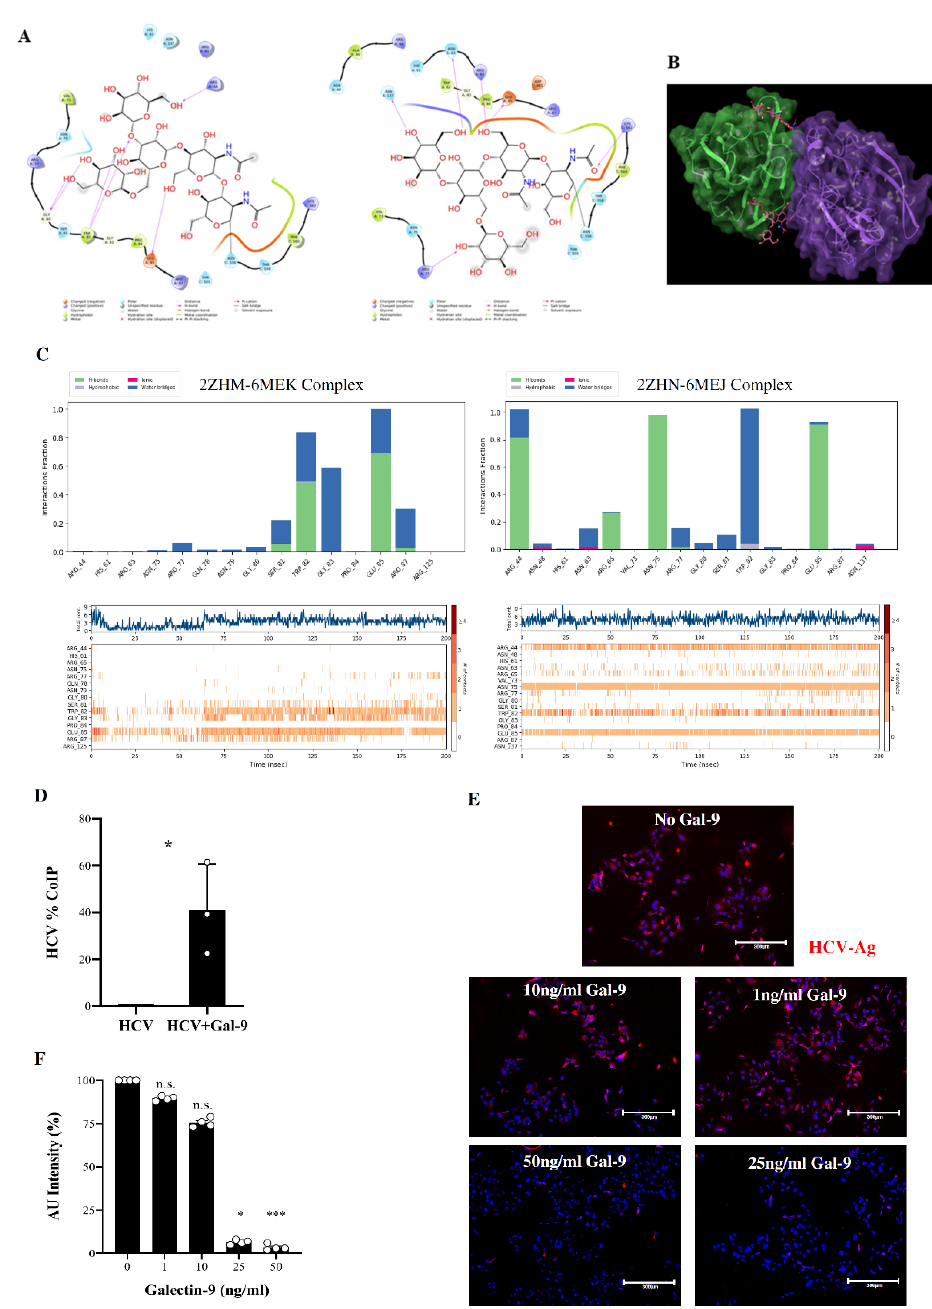
Figure 6. In silico and functional characterization of neutralizing interactions between HCV and galectin-9. ( A ) On the left, ligand interaction diagram of HCV E2 carbohydrate from PDB 6MEJ and galectin-9 CRDs from PDB 2ZHM; on the right, ligand interaction diagram of HCV E2 carbohydrate from PDB 6MEK and galectin-9 CRDs from PDB 2ZHN. ( B ) Galectin-9 CRDs–HCV E2 complex retrieved from a selected docking pose. The green chain is the galectin-9 CRDs from PDB 2ZHN, the purple chain represents HCV E2 from PDB 6MEJ, and the pink molecules are the sugar moieties belonging to E2. ( C ) On the top, bar plots of the interactions established between galectin-9 CRDs and HCV E2 during the MD trajectories; on the bottom, frequency occurrence of the interactions between the protein partners in the MD timeframe. ( D ) Bar graph showing the percentage of HCV bound to galectin-9, as assessed with the co-immunoprecipitation (CoIP) assay. HCV without ga- lectin-9 was used as a negative control. Each dot represents a technical replicate. Statistical analyses were performed using Student’s t -test ( p -value * ≤ 0.05). ( E ) Representative immunofluorescence staining of HCV-Ag (red color) in Huh7.5 cells infected with recombinant HCV preincubated with